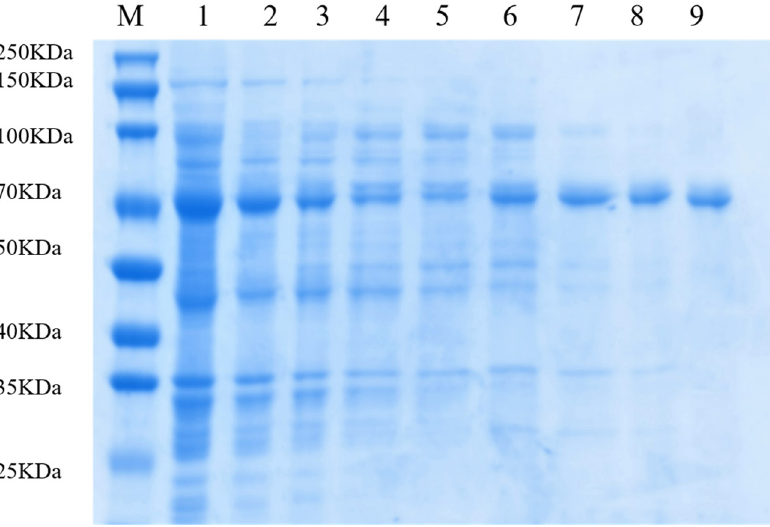
Figure 2. 10% SDS-PAGE of PsDex1711 after purification. 1: PsDex1711 crude enzyme solution; 2: Outflow liquid; 3–9: Elute nickel column with 20, 40, 60, 80, 100, 200, and 300 mM imidazole, respectively.